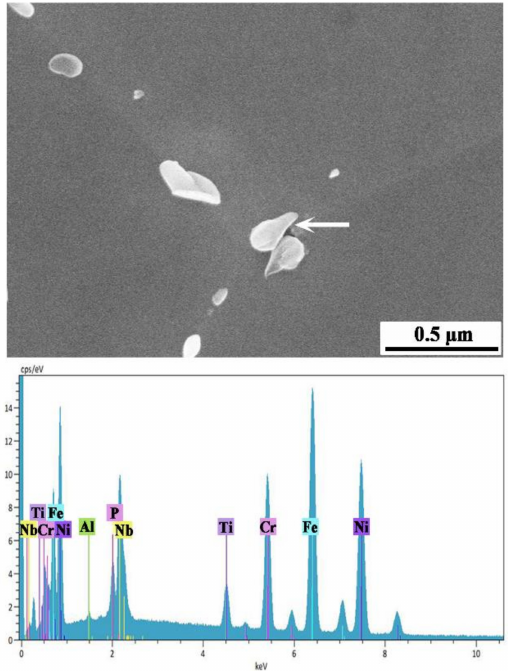
Figure 10. SEM image and EDS of the phosphide in alloy 4 held at 980 ◦ C for 10 min after direct aging heat